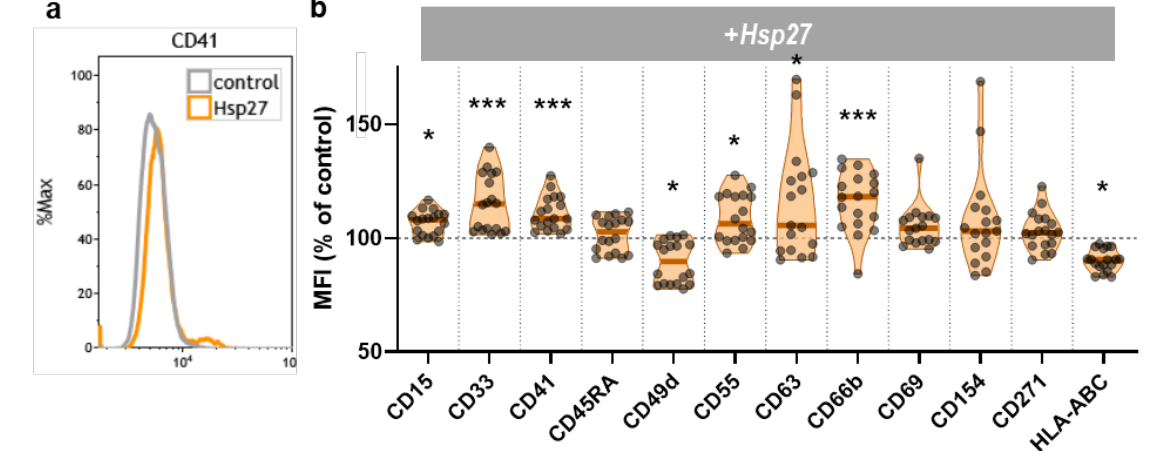
Figure 3. THP-1 surface marker expression. ( a ) representative flow cytometry overlay histograms of CD41 fluorescence in THP-1 cells cultured in the presence or absence of Hsp27; ( b ) normalized mean fluorescence intensity (MFI) of twelve surface markers of the THP-1 cells 144 h after Hsp27 exposure. Statistical analysis was performed using an unpaired two-tailed t -test with p < 0.05 (*) and p < 0.001 (***). Table 1. Multiplex chemokine and cytokine measurement . The THP-1 cells were incubated in the presence or absence of Hsp27 and supernatants were collected 144 h later for multiplex chemokine and cytokine analysis performed using flow cytometry. Most analytes were below the detection limit (indicated by “<”); IL18 differed significantly (bold), as tested using a t -test. Concentrations are given in pg/mL.